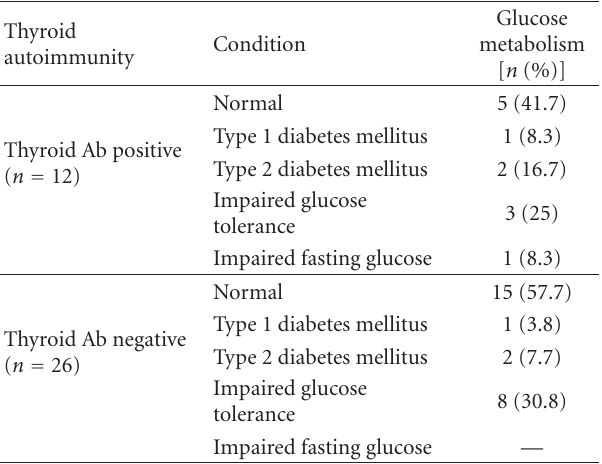
Table 2: Glucose abnormalities and thyroid autoimmunity in post- GDM women (group